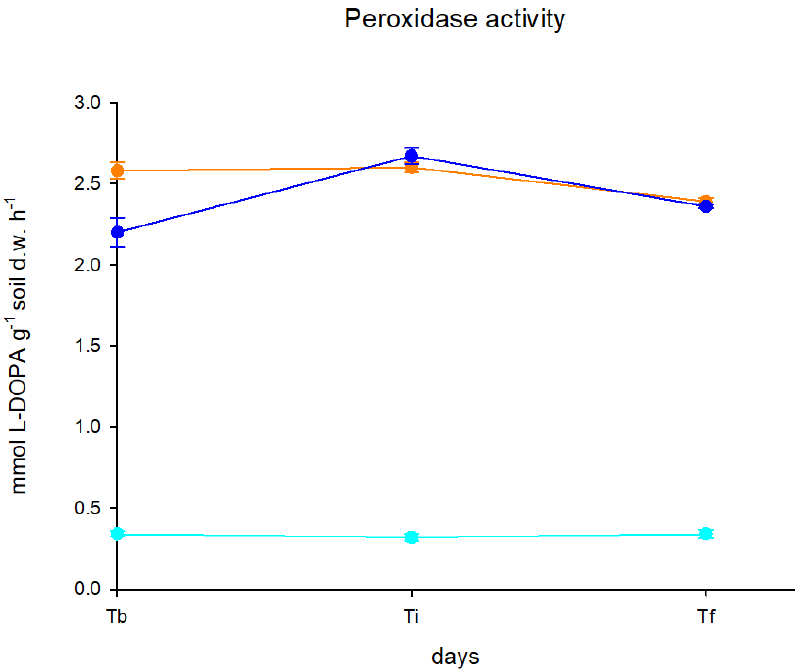
Figure 1. Temporal dynamics of laccase and peroxidase activities in natural (N1: yellow line, N2: blue line) and industrial (I: light blue line) soils during incubation. Vertical bars represent standard errors of the means ( n = 3). Table 2. Microbial groups in each soil system (N1, N2, I) at each sampling time (T b , T i , T f ), expressed as mean values ± standard errors in respect to the total microbial biomass (mol%).